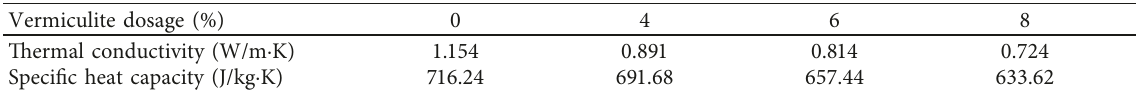
Table 2: Test results of the thermal parameters of asphalt